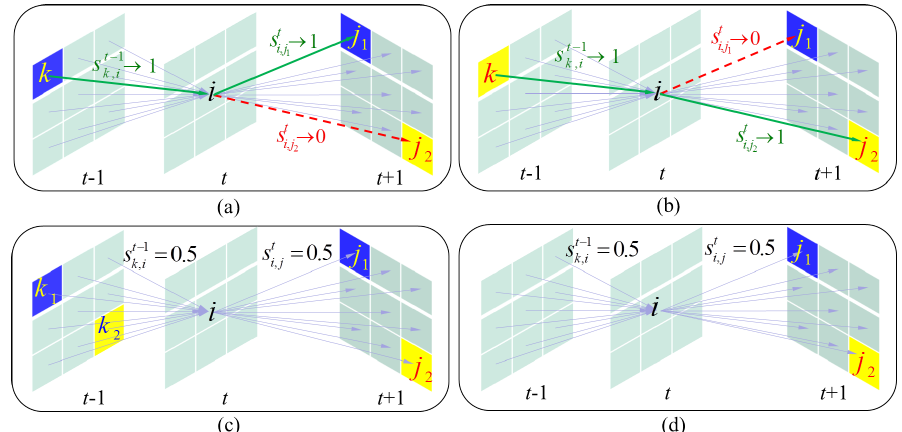
Figure 4. Illustration of similarity measurement when jersey color at the current frame ( t ) is unavailable: ( a , b ) one of its neighboring nodes ( k ) in previous frame can access the jersey color; ( c ) jersey color can be available in more than one node ( k 1 and k 2 ) at t − 1; ( d ) jersey color cannot be obtained for all of the neighboring nodes at t − 1. A green arrow here is called a relative strong match ( s → 1); a red dotted arrow is an impossible match ( s → 0); other gray arrows are possible matches ( s =